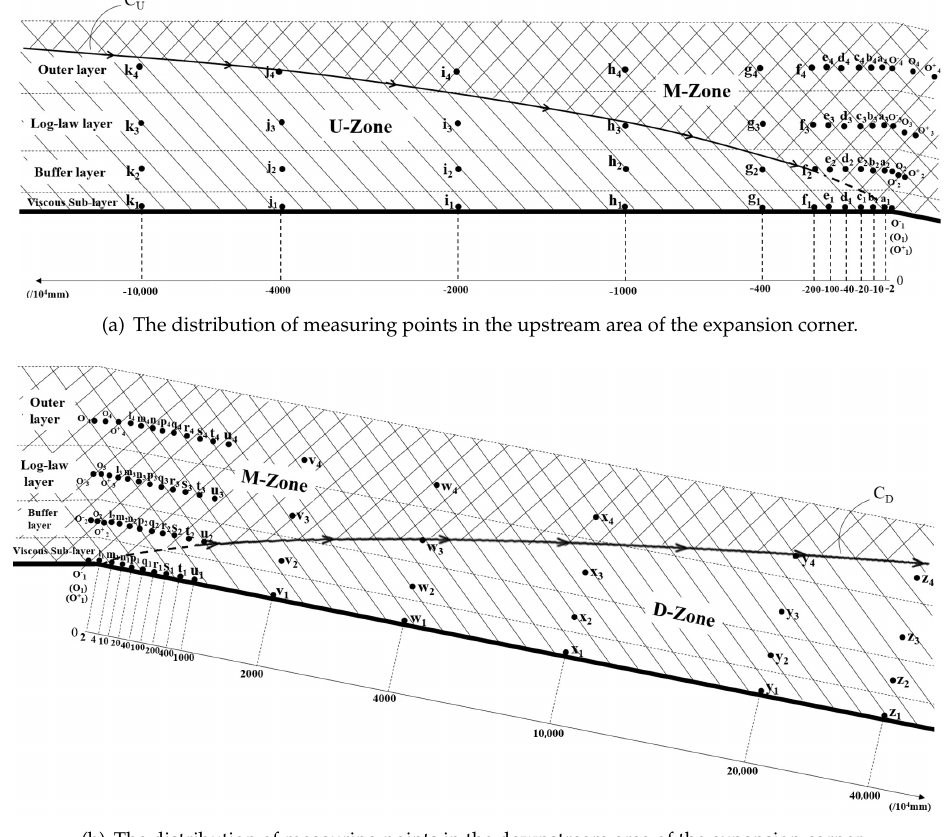
Figure 7. The distribution of measuring